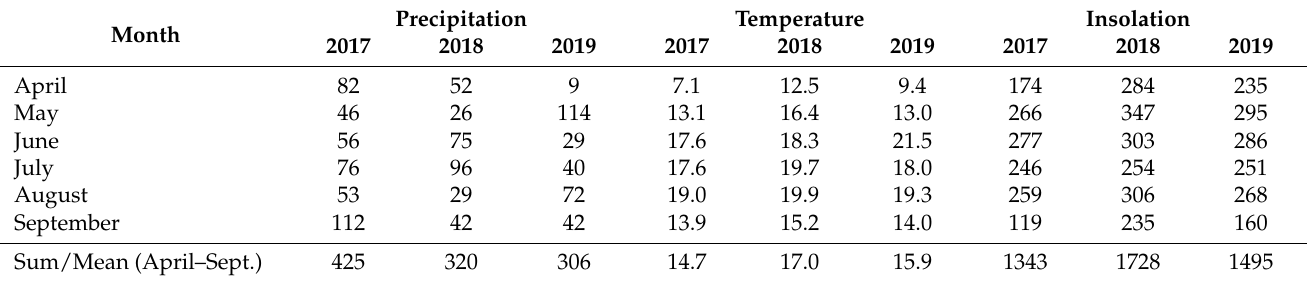
Table 2. Air temperature atmospheric precipitation and insolation values in